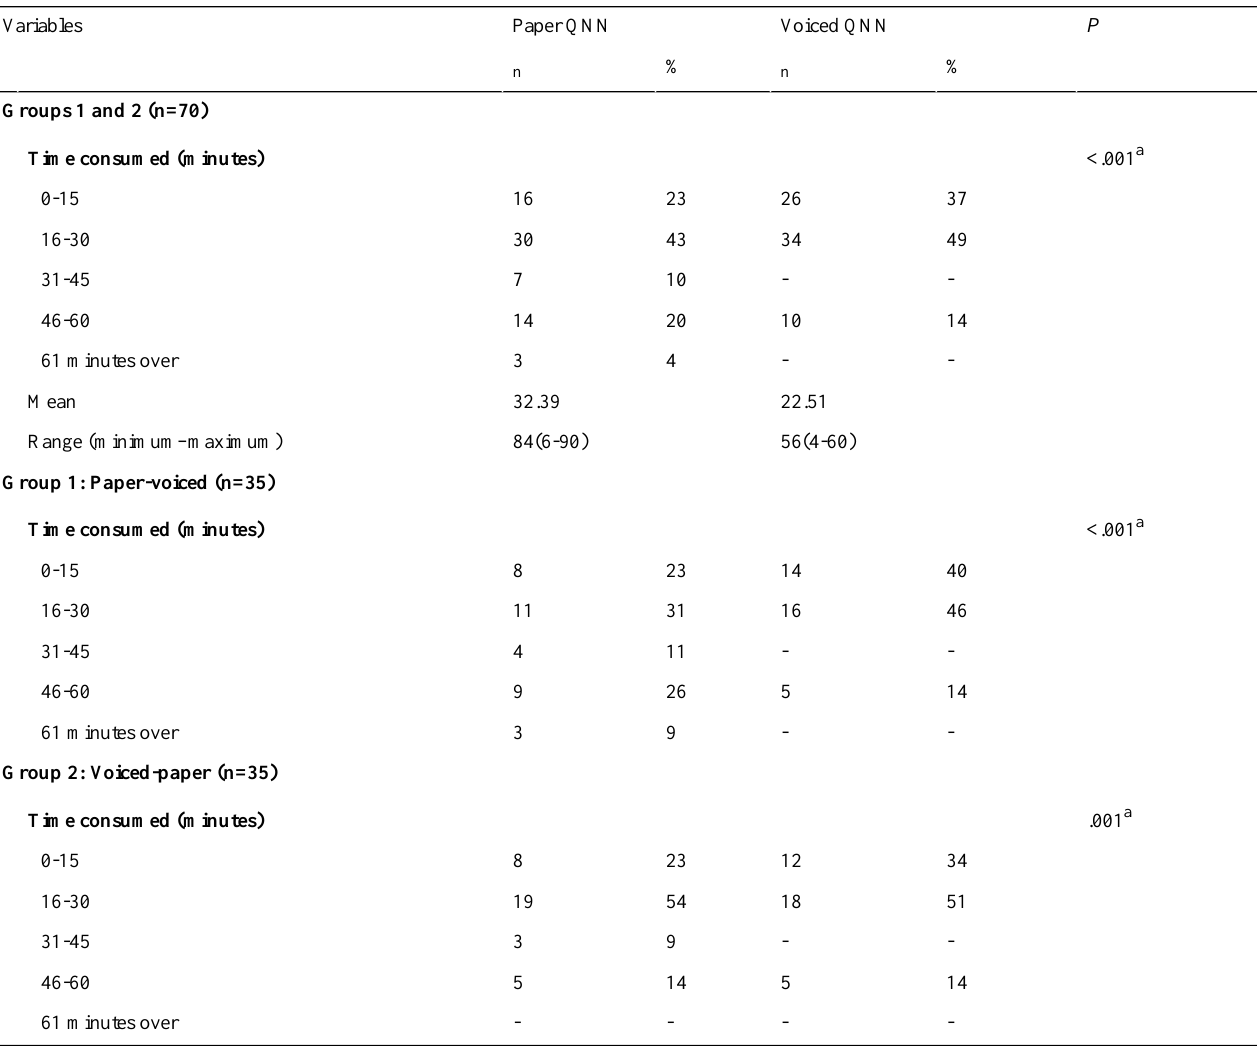
Table 2. Time consumed between paper-based and smartphone voiced questionnaire survey methods.